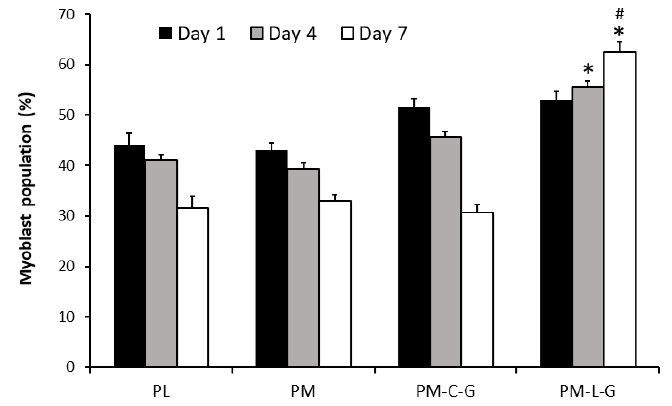
Figure 9. Graph is presenting the percentage of myoblast population. # indicates significance difference between groups; * indicates significance difference of myoblasts population from different culture conditions on the same day.